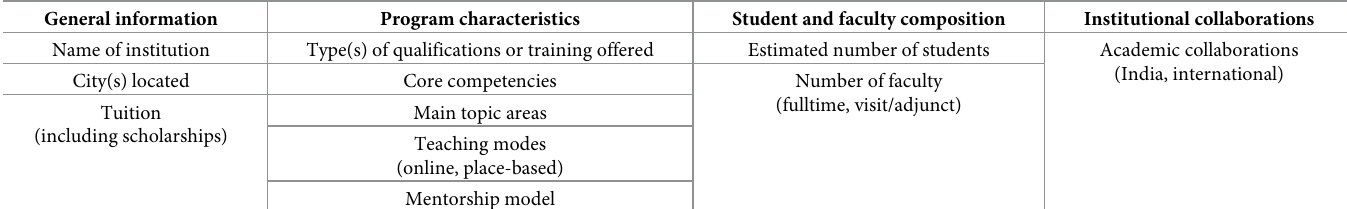
Table 1. Summary of variables captured in the desk